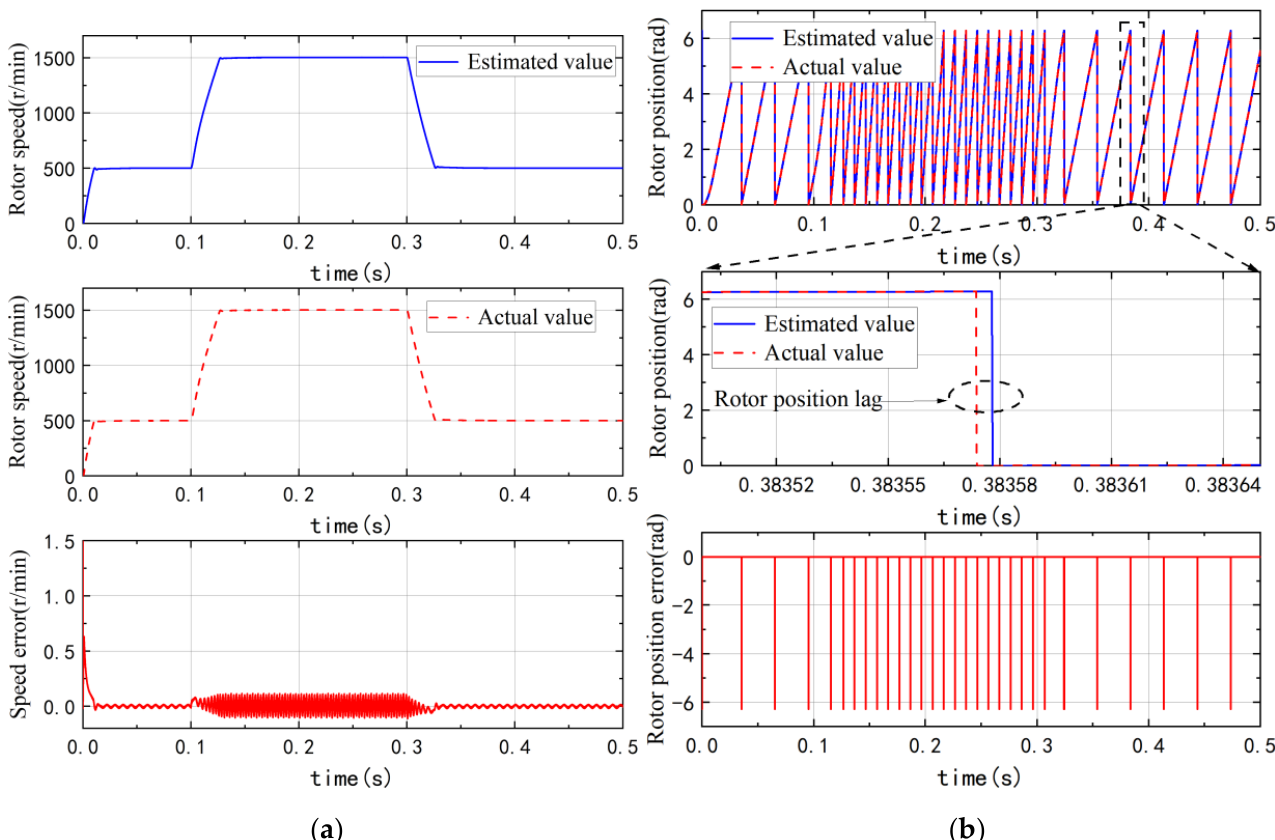
Figure 16. Speed and position estimation results of improved SMO with MPF at variable-speed operation: ( a ) rotor speed; ( b ) rotor position.